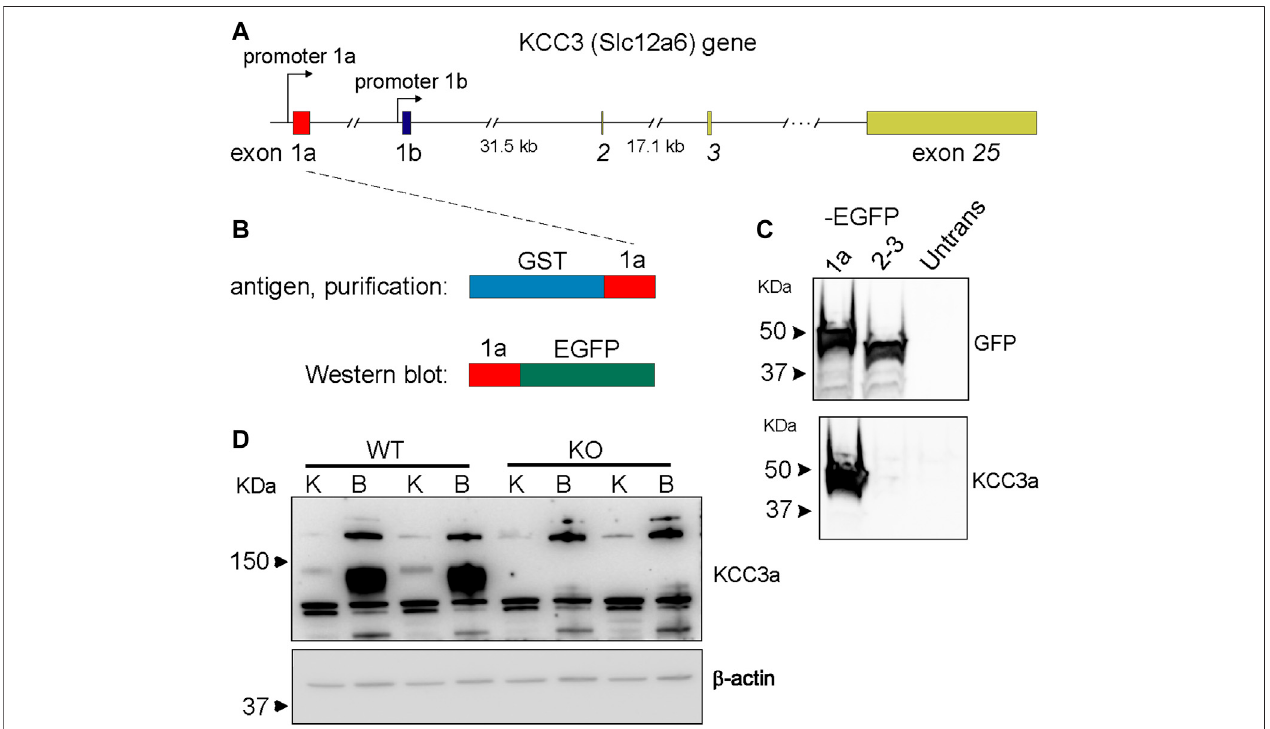
FIGURE1| Generation ofapotassiumchloride cotransporter3a(KCC3a) – speci fi cantibody. (A) Structure ofthe mouse Slc12a6 (KCC3)geneshowing alternative promotersandexons1aand1b,aswellasexons2,3,and25. (B) Glutathione-S-transferases(GST) – exon1afusionproteinusedtopurifytherabbitimmuneserumand fusionprotein exon1a – enhanced green fl uorescent protein (EGFP) puri fi edfrom transfected HEK293 cellsused toassess antibody speci fi city. (C) Immunoblotshowing EGFP expression in HEK293cells transfected with1a-EGFP or 2-3-EGFPbut not untransfected cells. KCC3 signal in cells transfected with1a-EGFP, but not 2-3- EGFPoruntransfectedcells. (D) Immunoblotshowsthebandat~130 kDawithkidney(K)andbrain(B)samplesfromwild-typemice,butnotfromKCC3-knockout(KO) mice. Notably, there is an abundance of KCC3a in brain tissue, compared to the kidney.